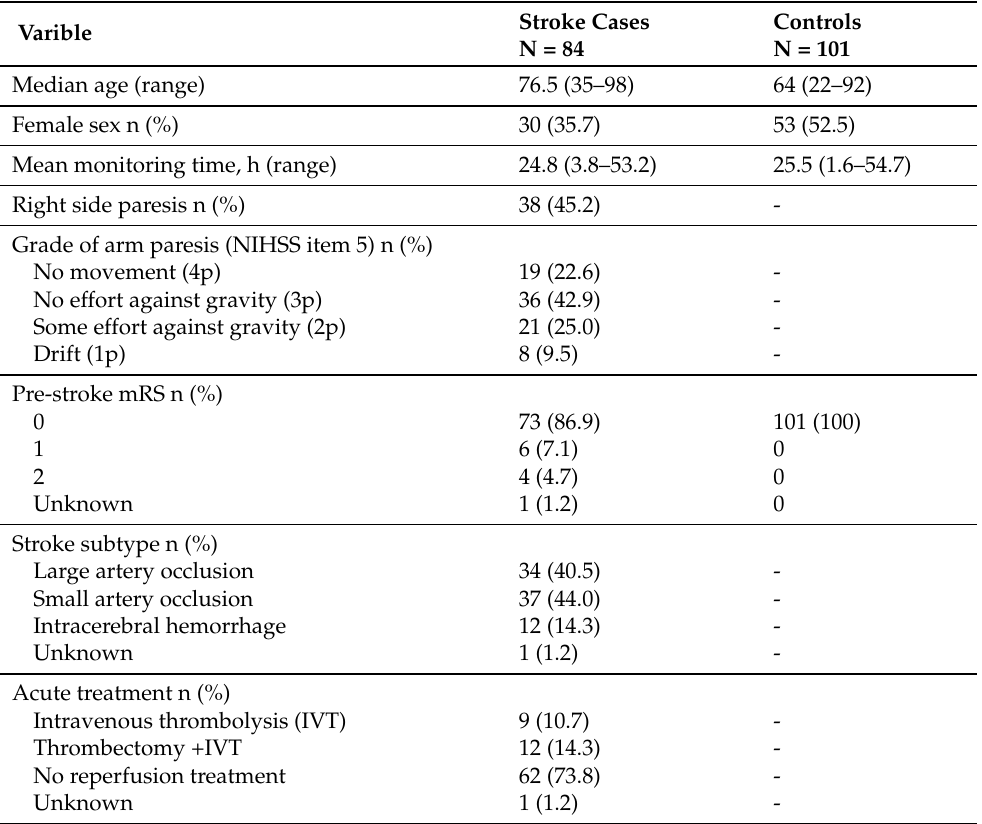
Table 1. Study population demographics, including stroke sub-type and severity of the arm mo- tor